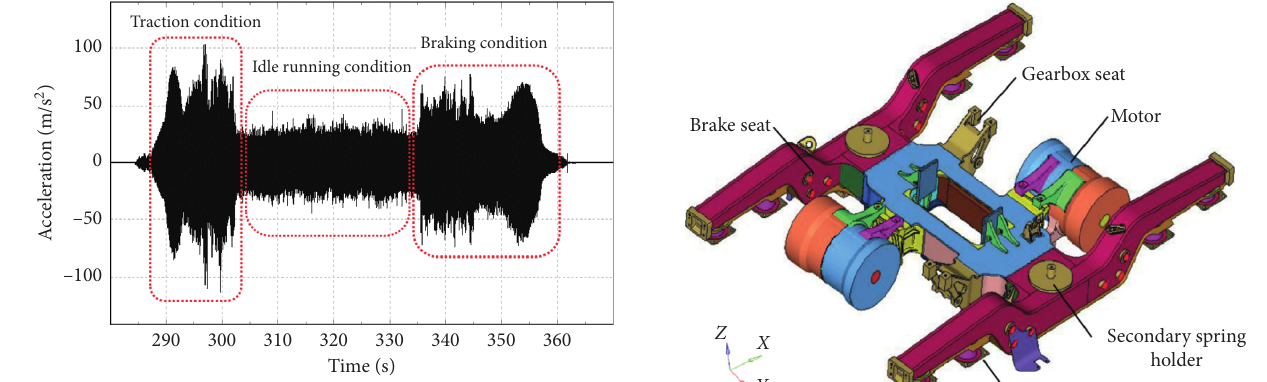
Figure 1: Vertical acceleration vibration signal of a metro motor from station A to station B. Figure 2: Finite element model of the bogie